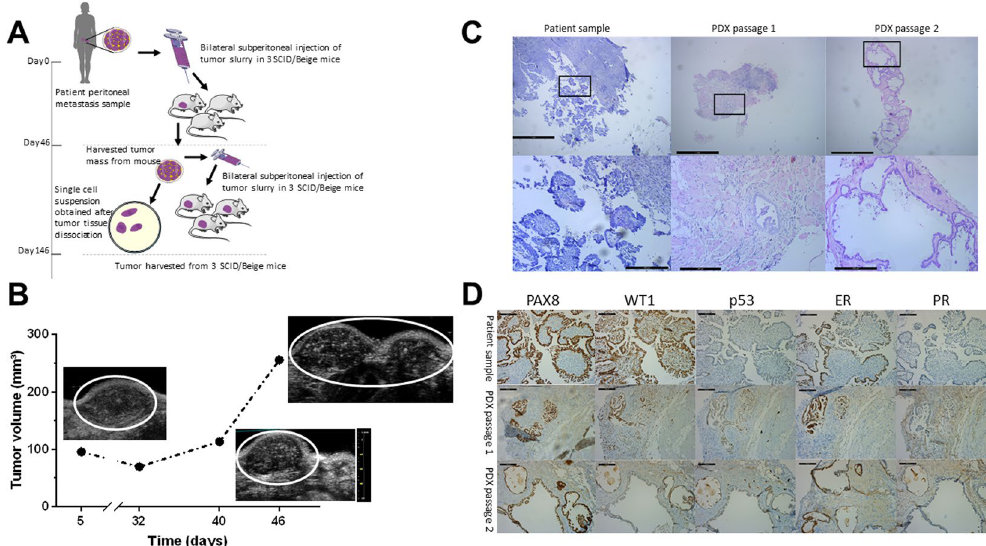
Figure 1. Establishment of the PM-PDX model. ( A ) Schematic representation of the protocol for PM-PDX model establishment. Fresh human peritoneal metastasis samples, originating from serous ovarian cancer, were collected and subperitoneally injected as a tumor slurry in SCID/Beige mice. The tumor is harvested once it is ready for passaging, tumor tissue is collected and prepared for subperitoneal injection in a new group of mice or processed into a single cell suspension. This figure was created by the first author E. De Thaye using the image bank of Servier Medical Art (https://smart.servier.com). Servier Medical Art by Servier is licensed under a Creative Commons Attribution 3.0 Unported License (https://creativecommons.org/licenses/by/3.0). ( B ) Assessment of tumor volume over time using ultrasound imaging. ( C ) Tumor section slides were stained for H&E to compare histology of the PDX tumors with the corresponding patient metastasis. The lower row shows a close-up of the area within the black rectangle. Scale bars represent 1 mm for the upper row and 200 µ m for the lower row. ( D ) Comparative study of tumor sections stained for PAX8, WT1, p53, ER and PR, as indicated. Scale bars represent 100 µ